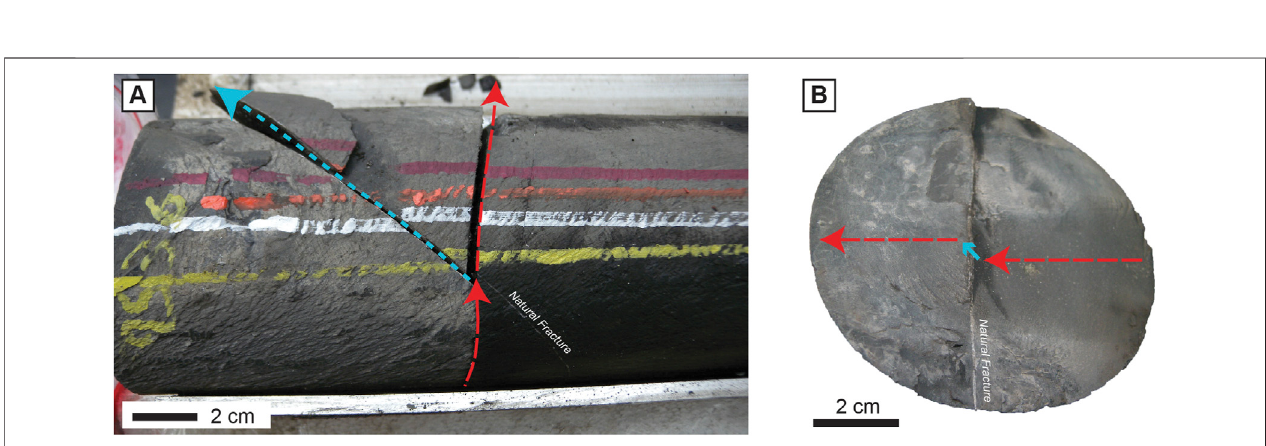
FIGURE 6 | (A) Hydraulic fracture #376 propagating to the east (red) and being split and diverted along the NE-oriented part of a natural fracture (light blue). (B) Hydraulic fracture #579 (fracture face) propagating (red) and taking a slight jog up along a natural fracture (light blue) before reorienting and continuing to propagate.